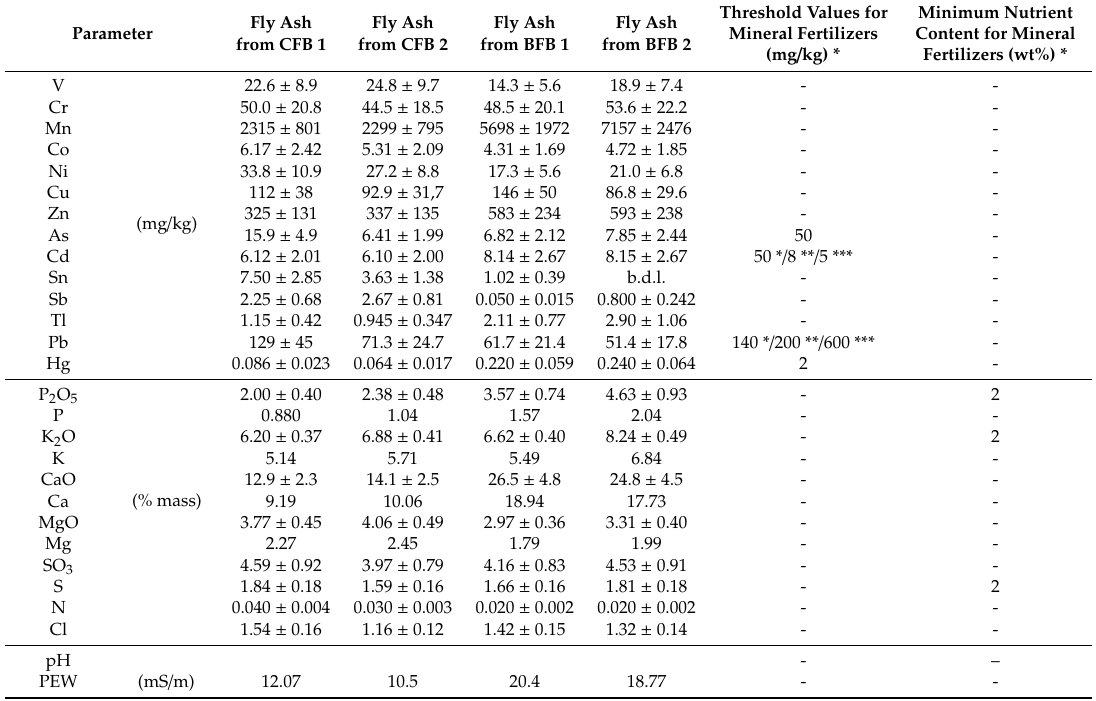
Table 2. Chemical composition of fly ash from biomass combustion in fluidized bed